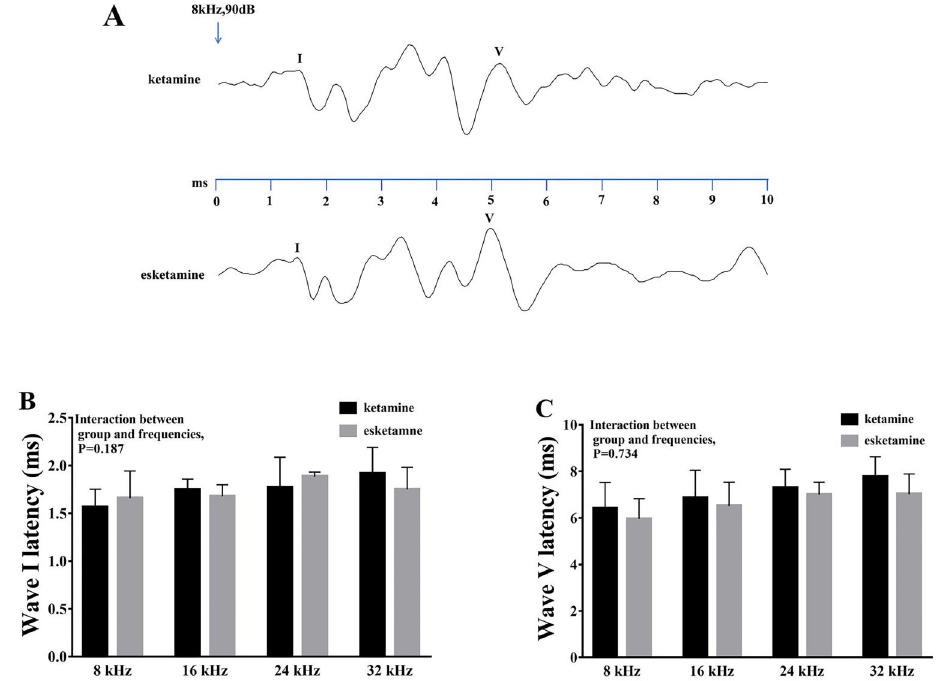
Figure 2. Esketamine did not affect nerve fi ber recruitment in mice. A , Peak latencies of waves I and V with a stimulus of 8 kHz and 90 dB sound pressure level. B and C , Esketamine did not reduce the peak latencies of waves I or V at the four frequencies assessed. Data are reported as means ± SE. ANOVA was used to compare the groups.